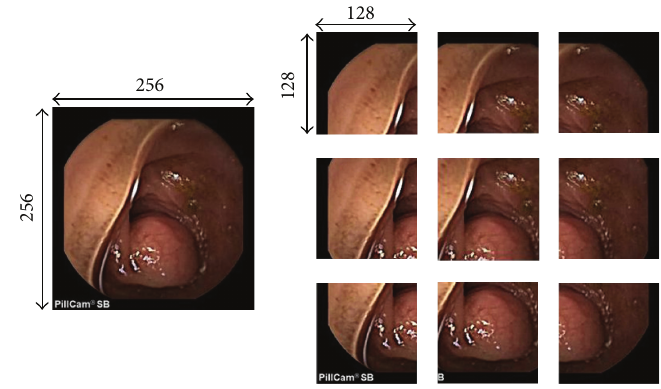
Figure 3: Patches chosen from one WCE